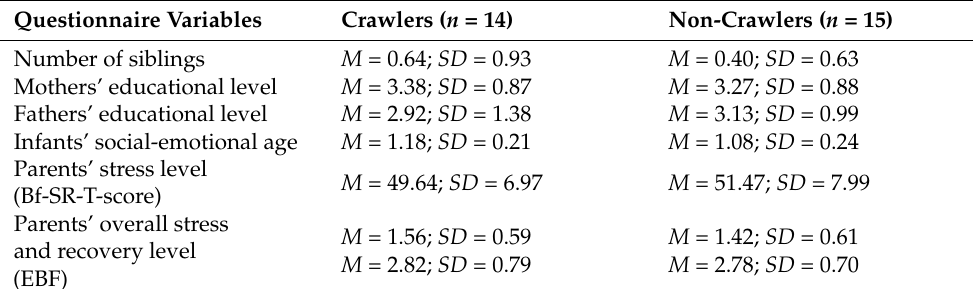
Table 1. Means and standard deviations of the different